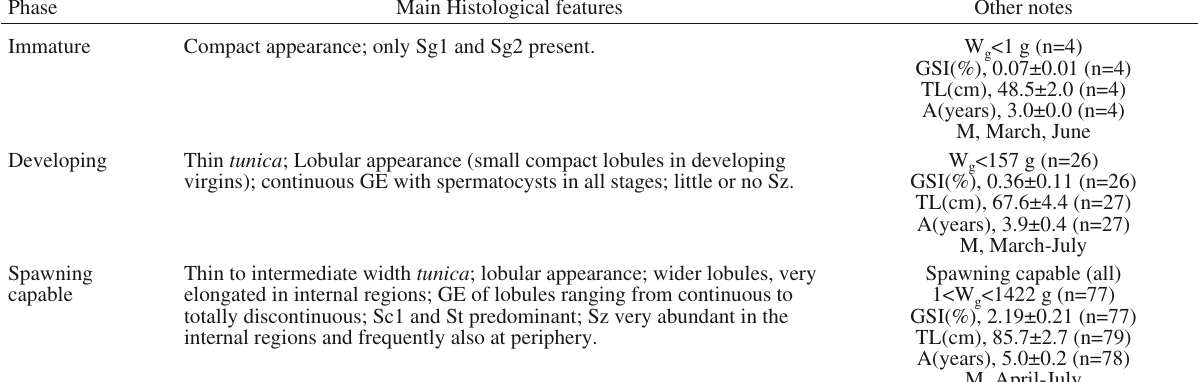
Table 3. – Histological grading system of the meagre testis. Sg, spermatogonia; Sc1, primary spermatocytes; Sc2, secondary spermatocytes; St, spermatids; Sz, spermatozoa; GE, germinal epithelium; W , weight of gonad; GSI, Gonadosomatic index (calculated as in Table 2; g mean±s.e.); TL, total length (mean±s.e.); A, age (mean±s.e.); M, month(s) of occurrence.